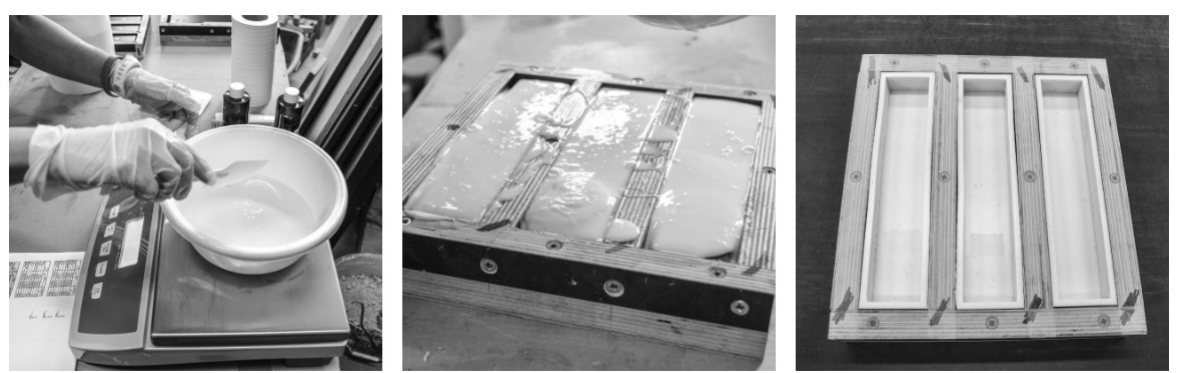
Figure 1. Illustration of silicone moulds preparing.